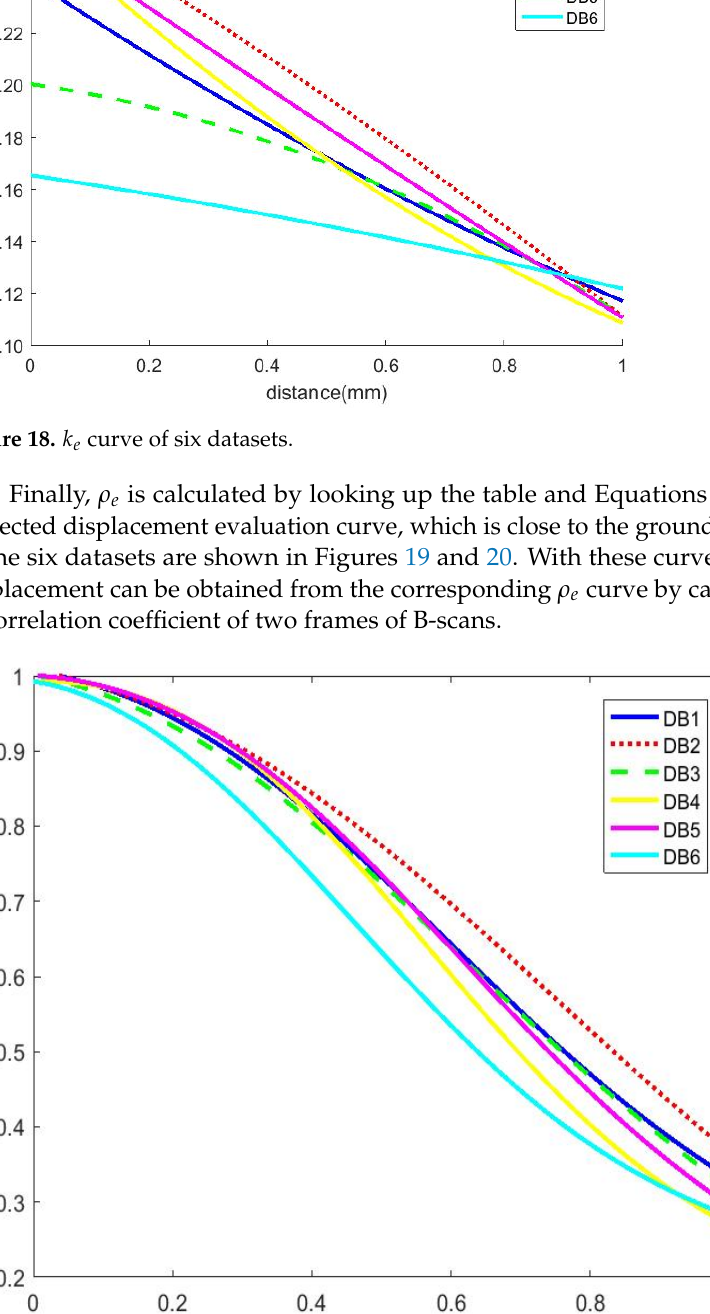
Figure 19. Axial displacement correlation coefficient of ρ e